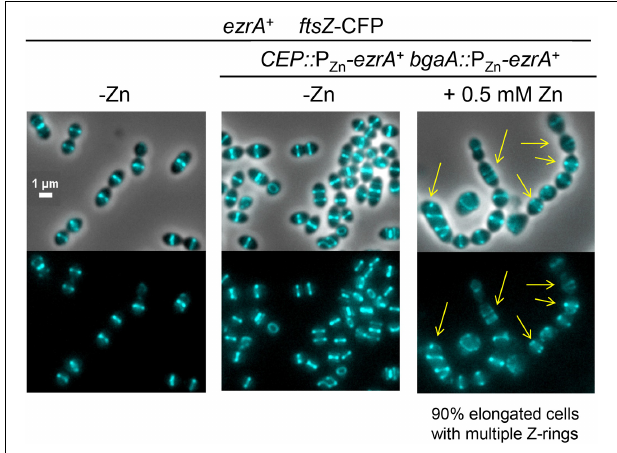
FIGURE 6 | Overexpression of EzrA leads to extra Z-rings in cells expressing FtsZ-CFP in BHI. FtsZ-CFP was localized in otherwise wild-type cells (IU13406) or ezrA merodiploid strain (IU13700; ftsZ - cfp ezrA + //CEP::P Zn - ezrA + // bgaA ::P Zn - ezrA + ) in BHI 37 ◦ C 5% CO 2 . Cells were grown from OD 620 ≈ 0.003 without supplemented ZnCl 2 (- Zn) or supplemented with ZnCl 2 (0.5 mM ZnCl 2 and 0.05 MnSO 4 ) to overexpress ezrA + . Yellow arrows point to cells with extra Z-rings. Images were obtained after 4 h of growth in the presence of ZnCl 2 /MnSO 4 . Ninety percent of the cell population of EzrA-overexpressed cells were elongated and contained multiple Z-rings.